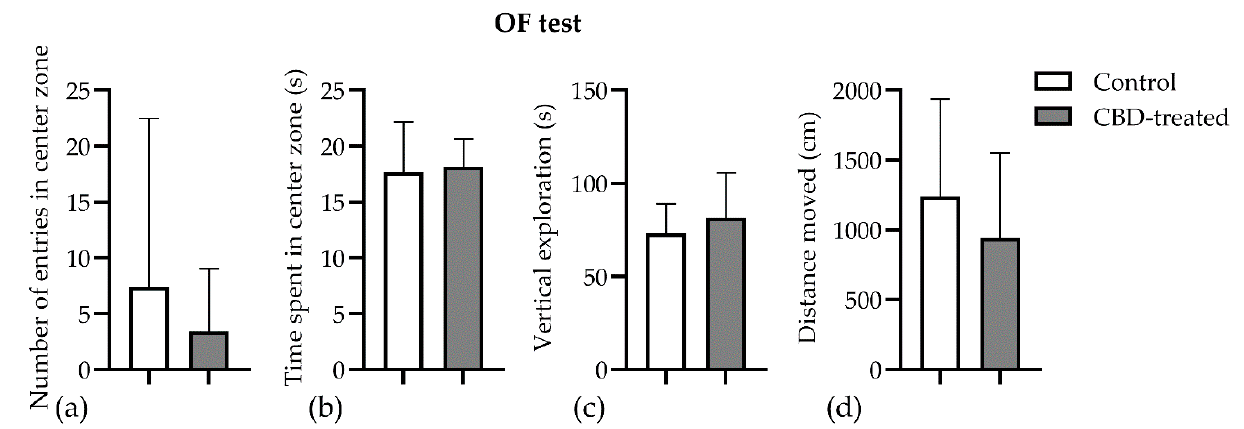
Figure 5. Assessment of locomotor activity in the open field. Rats were submitted to a PTZ ‐ kindling protocol with or without chronic cannabidiol (60 mg/kg body weight) administration (mean ± SEM, n = 18). ( a ) The number of entries in the center zone; ( b ) time spent in the central zone of the arena, defined as a 30 × 30 cm square out of an 60 × 60 cm total surface of the arena; ( c ) the vertical exploration of the animals was expressed as the time spent leaning on the walls of the arena; ( d ) total distance moved during the 5 min testing session. CBD, cannabidiol. Data are expressed as mean ± SEM ( n = 7–11) for each parameter.